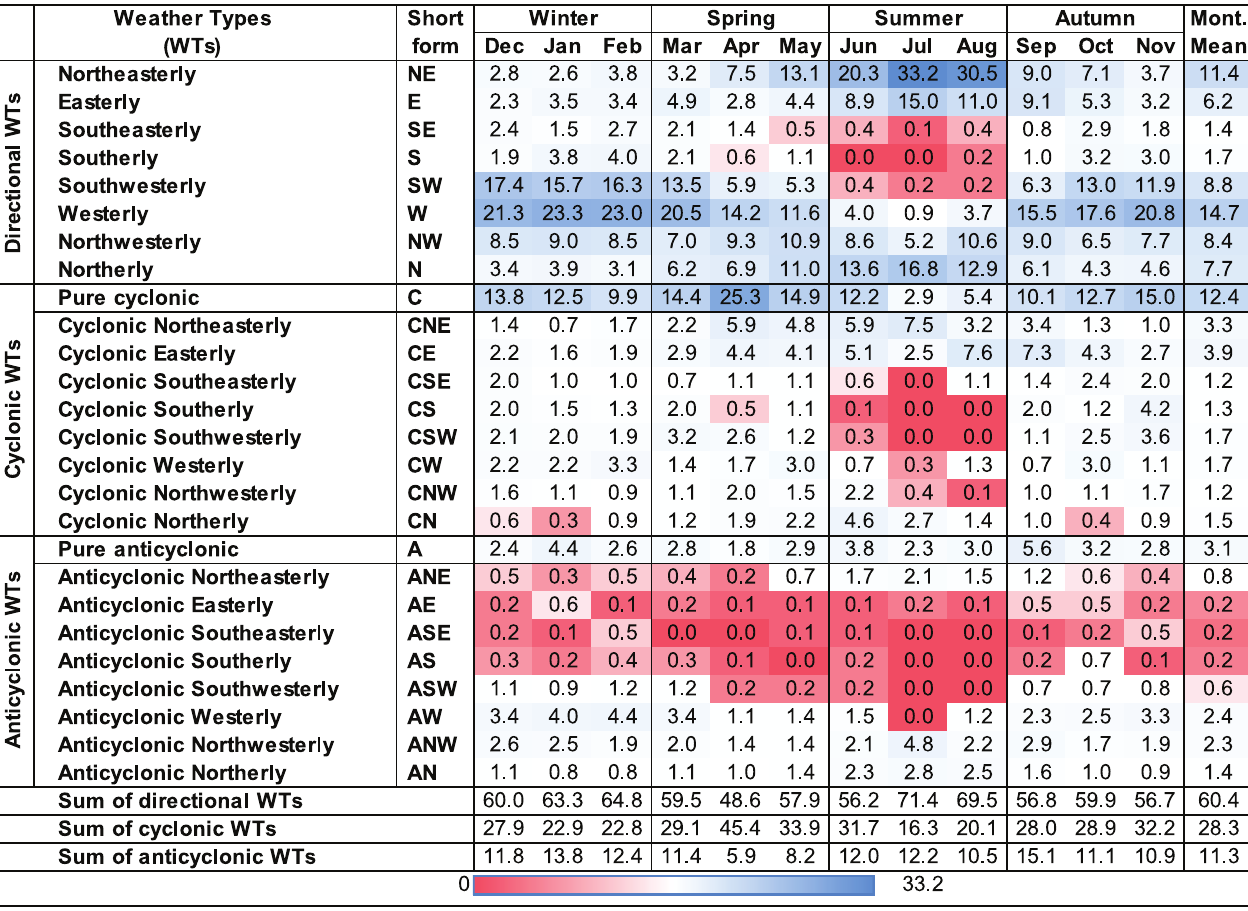
Table 3 | Percentage Contribution of each WT to total monthly Iberian precipitation.